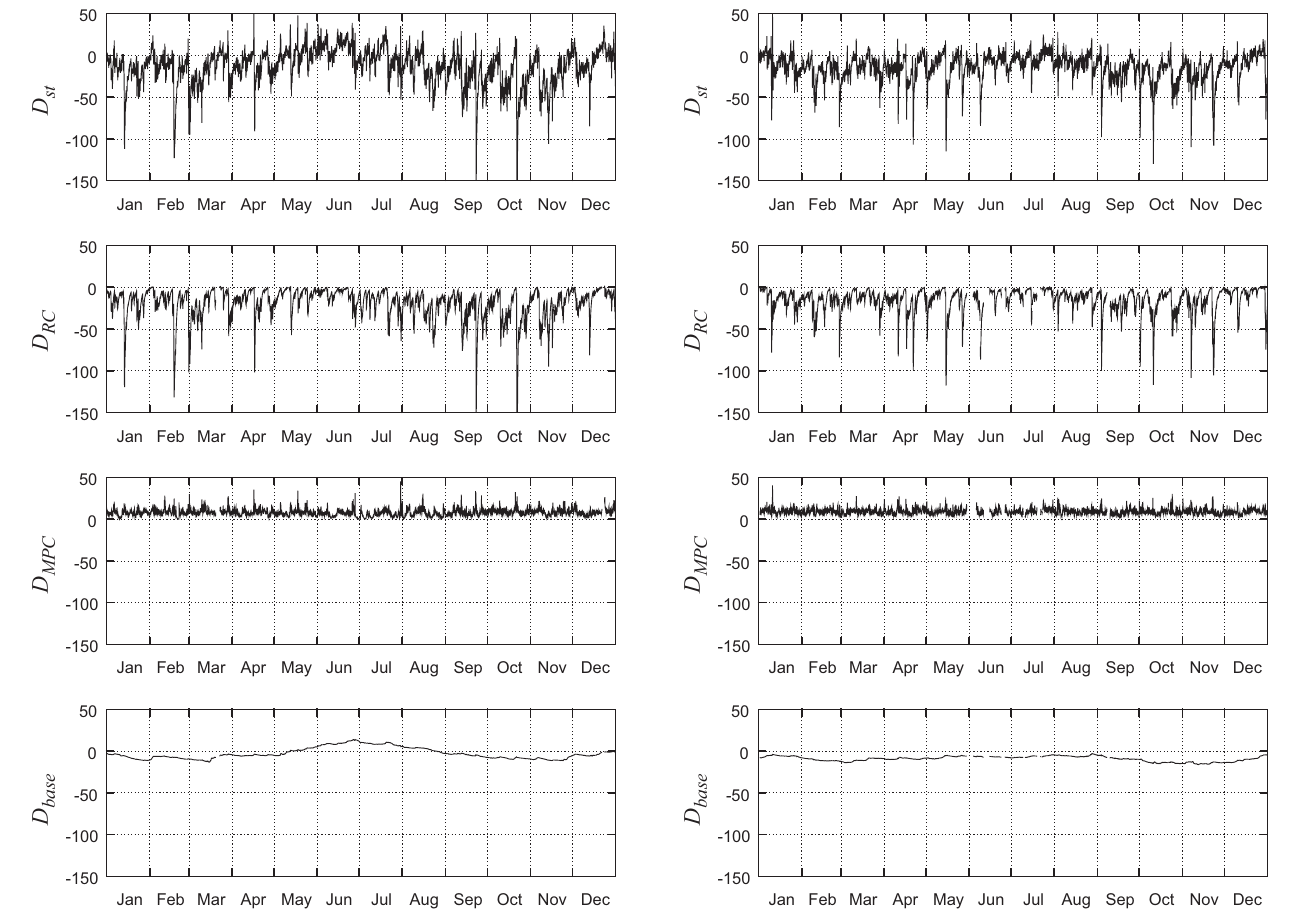
Fig. 2. Variation of the D st index (top panel) and the estimated variations of D RC (second panel), D MPC (third panel), and D base (bottom panel) for one year in 1999.